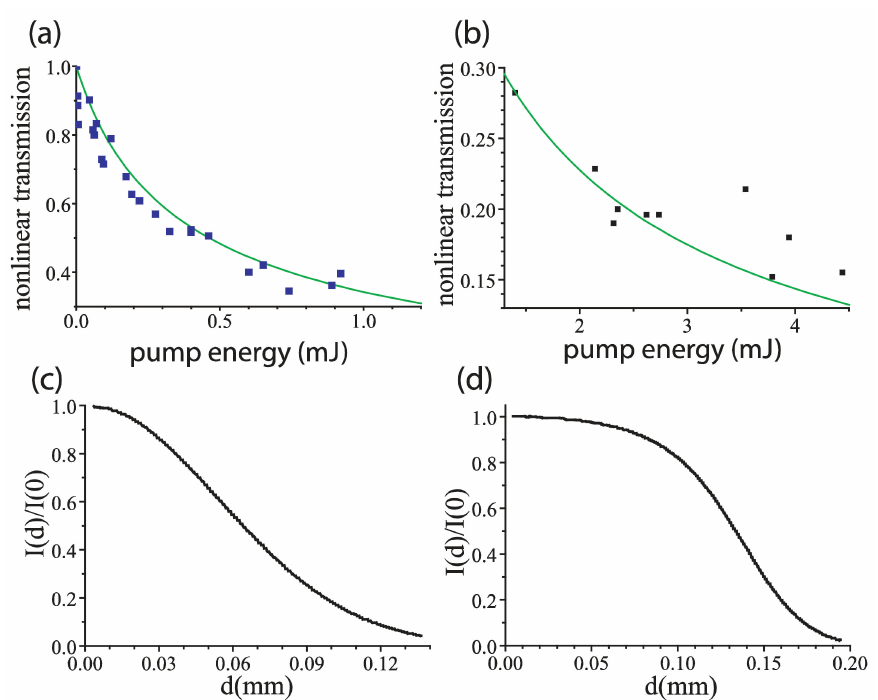
Figure 2. Nonlinear transmission of the 100 ps 0.532 µ m laser radiation in the 5 cm-thick layer of Ag nanoparticle suspension measured in two domains of pulse energies, ( a ) below 1 mJ, ( b ) 1 ÷ 4.5 mJ. Experimental points are given by rectangles. Normalized output radial intensity profiles are shown below the plots: ( c ) low-distorted near-Gaussian profile at low pulse energies and ( d ) heavily distorted profile at 1 ÷ 4.5 mJ pulse energies. Green lines in ( a , b ) show the fitting according to Equation (2).